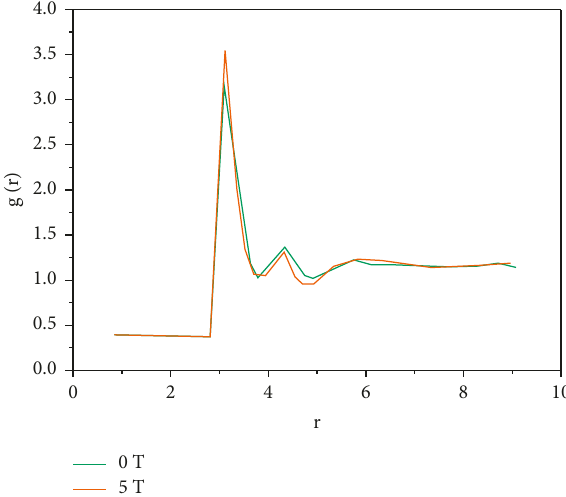
Figure 6: Effect of magnetic field on microstructure of 3.5% NaCl solution g